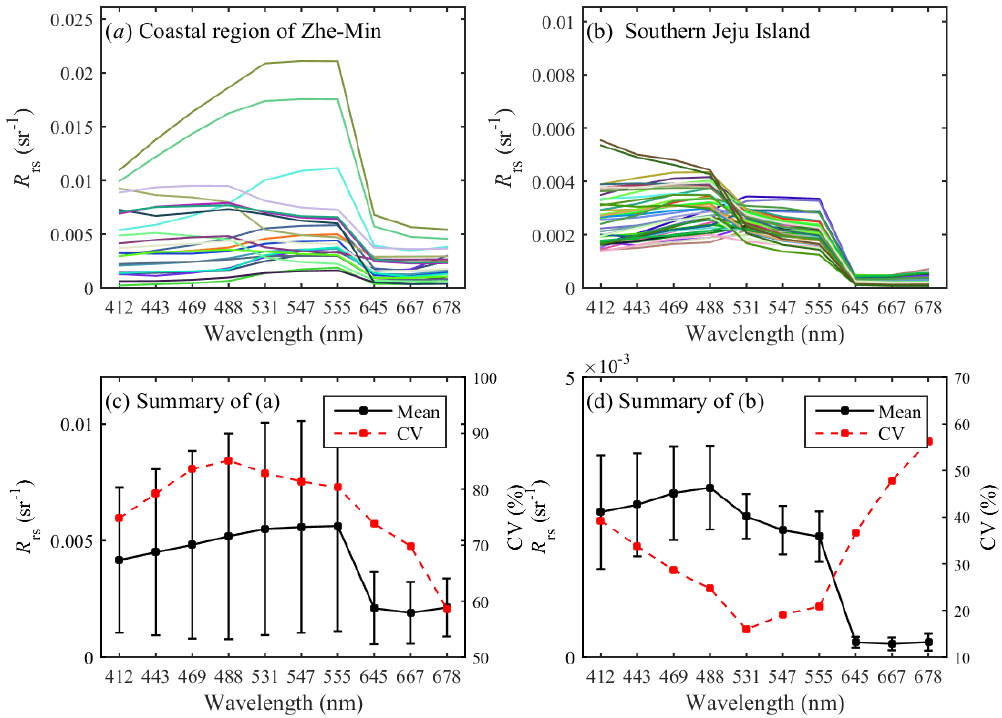
Figure 2. R rs (λ) spectra at MODIS wavelengths collected in the coastal region of Zhe–Min (a) and southern Jeju (b) ; mean spectra and coefficient of variation (CV) of R rs (λ) in the coastal region of Zhe–Min (c) and southern Jeju (d) . The CV is derived as the standard deviation (SD) over the